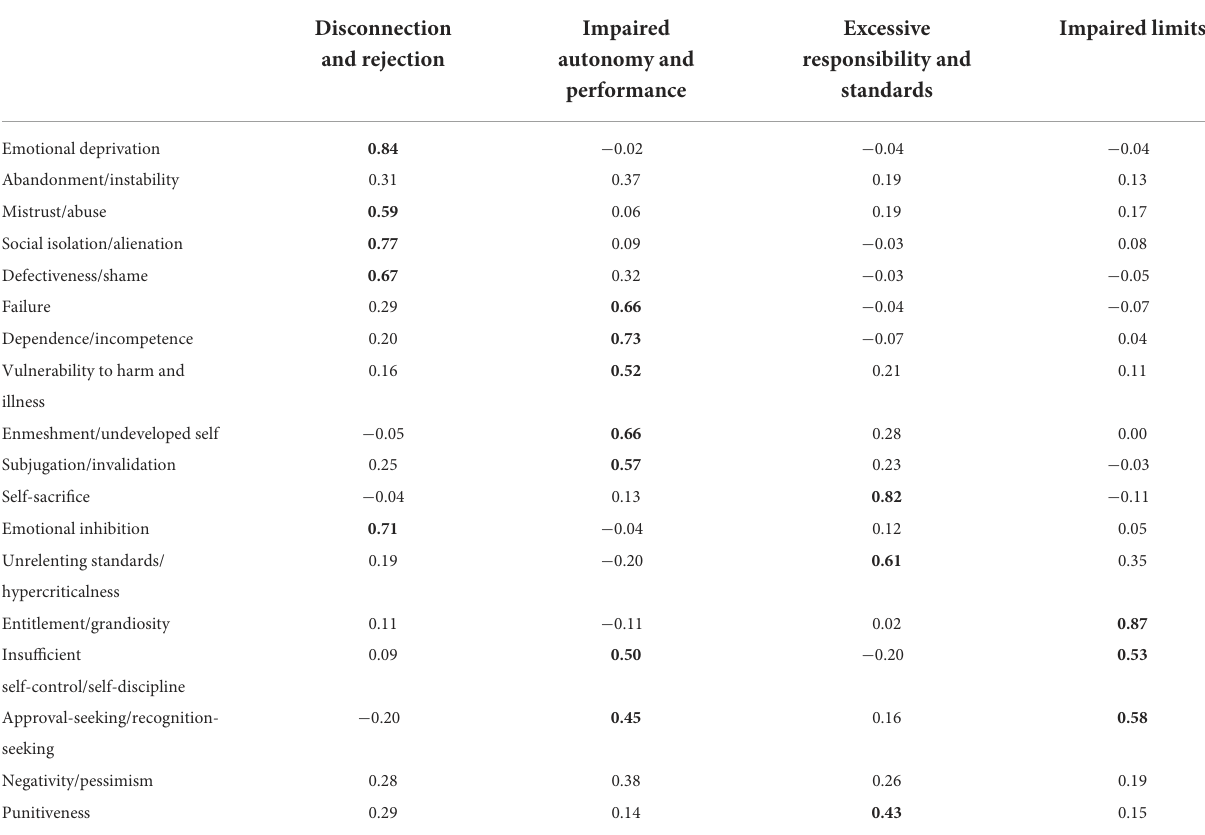
TABLE 5 Pattern matrix of the four-factor solution.